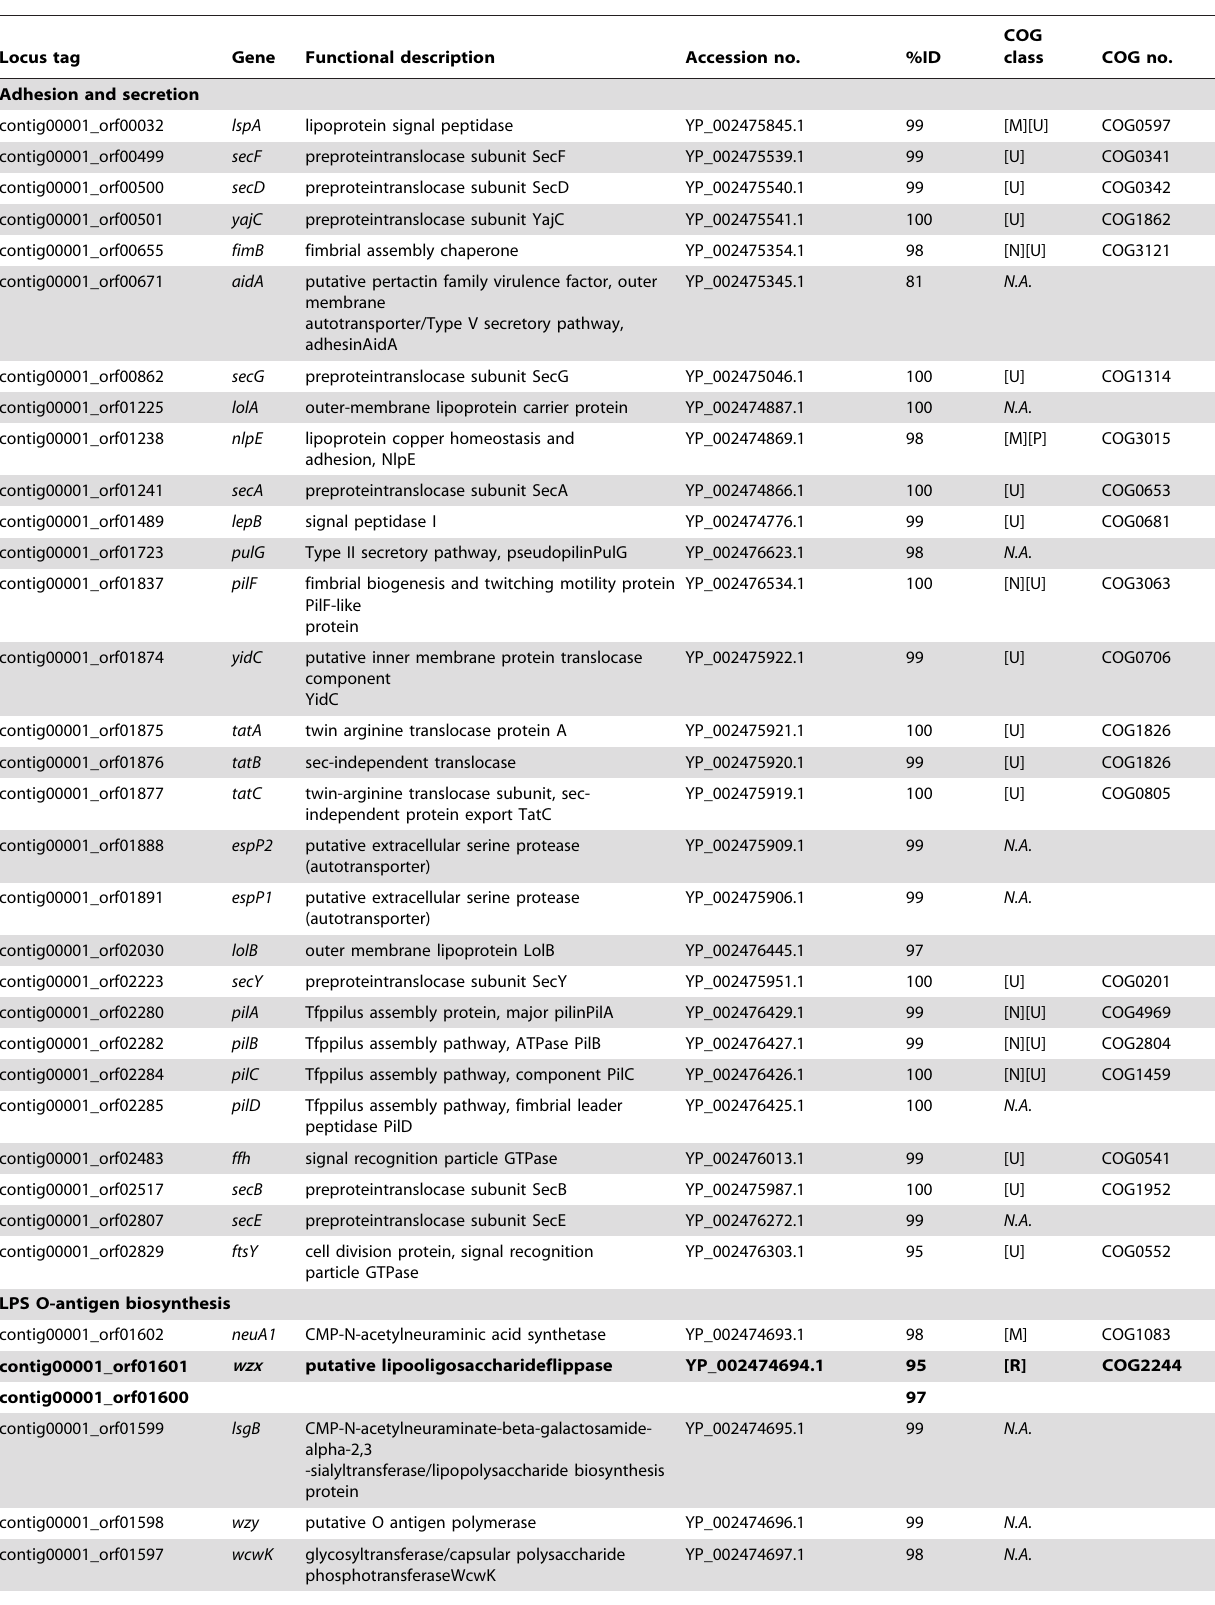
Table 4. Identification of other potential virulence factors in H. parasuis ZJ0906 genome.